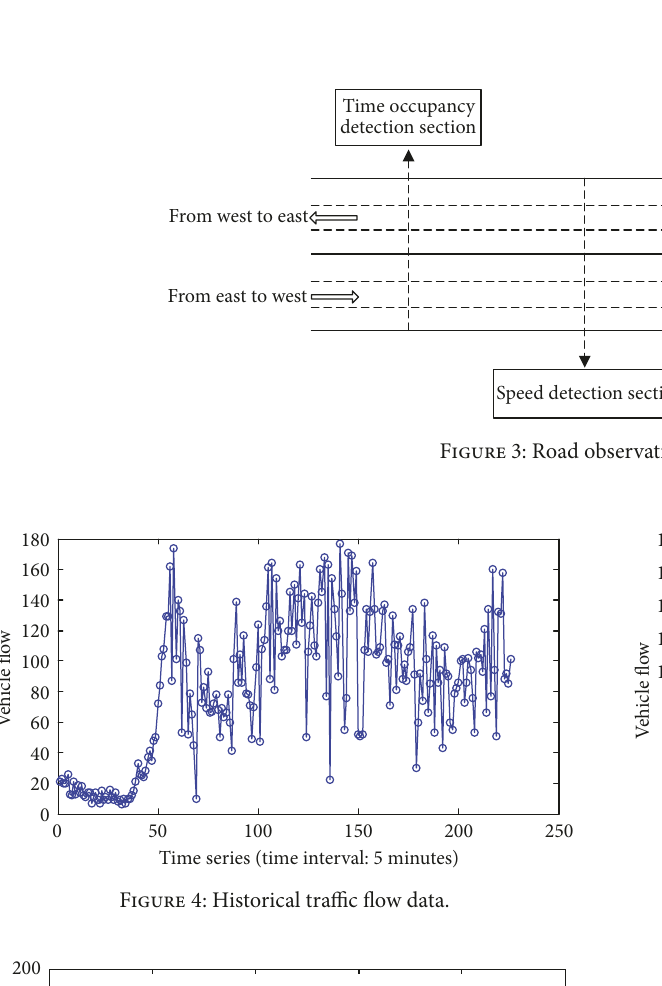
Figure 6: Predictive results of grey Markov model.